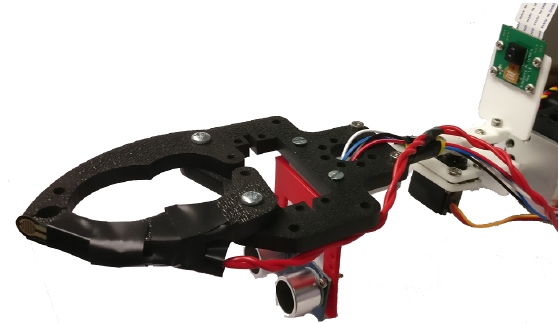
Figure 6. End e˙ector with the camera module, force and proximitysensor